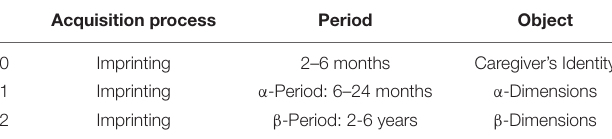
TABLE 1 | Sensitive periods and imprinting.